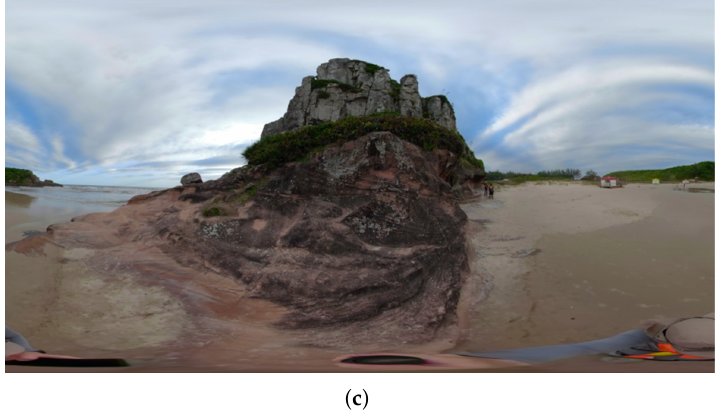
Figure 4. ( a ) Front view. ( b ) Back view. ( c ) Equirectangular image. Images captured by the GoPro Fusion camera, with the independent result of each front ( a ) and back ( b ) lens and the equirectangular image after the stitching process ( c ). Notice that information in C is a result of special processing involving integration between both fisheye side acquisitions.